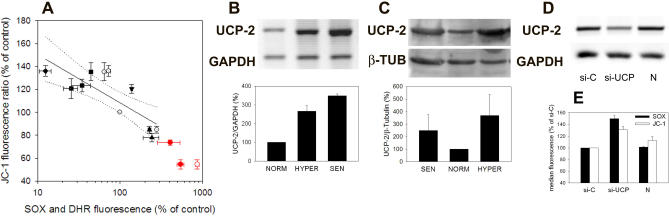
Cellular ROS Levels Control MMP via UCP-2 Expression(A) Interventions that modify ROS result in an inverse change in MMP. Fibroblasts were grown under 5% (squares) or 40% (triangles) oxygen. Cells were also treated with the ROS scavenger PBN (cross-haired square and inverted triangle) or transfected with an SOD3 transgene [34] (diamond). Open symbols: MitoSOX, filled symbols: DHR. Controls (circles) were set as 100% for each experiment. Data are mean ± s.e.m from three to five experiments per treatment. Solid line: linear regression, dotted lines: 95% confidence intervals. Red symbols: senescent and SES MRC-5 fibroblasts.(B) UCP-2 expression in MRC-5. Top: Duplex-RT-PCR of UCP-2 versus GAPDH. Bottom: quantification of results, n = 2, mean + difference between means (Δm). NORM indicates young controls proliferating under normoxia, HYPER indicates young cells under 40% hyperoxia, and SEN indicates senescent cells under normoxia.(C) UCP-2 versus β-tubulin (β-TUB) protein content. Top: Immunoblots; bottom: quantification of results. Data are mean + Δm, n = 2.(D) Suppression of UCP-2 expression in MRC5 fibroblasts by treatment with siRNA (si1-UCP), but not with a scrambled control siRNA (si-C) as measured by RT-PCR. N indicates untreated control.(E) si1-UCP expression results in increased mitochondrial superoxide levels (SOX) and increased MMP (JC-1 ratio). Data are mean + Δm, n = 2. Similar results were obtained with si2-UCP and si3-UCP.